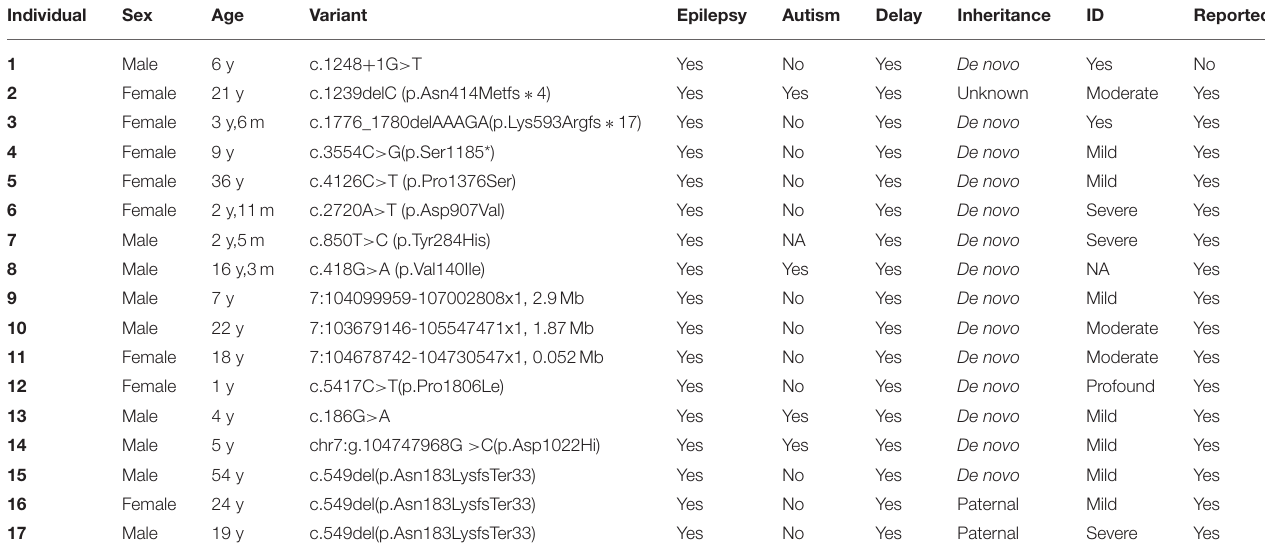
TABLE 1 | Clinical manifestation of 17 patients with epilepsy diagnosed with ODLURO syndrome. Individual Age Variant Epilepsy Autism Delay Inheritance ID Reported